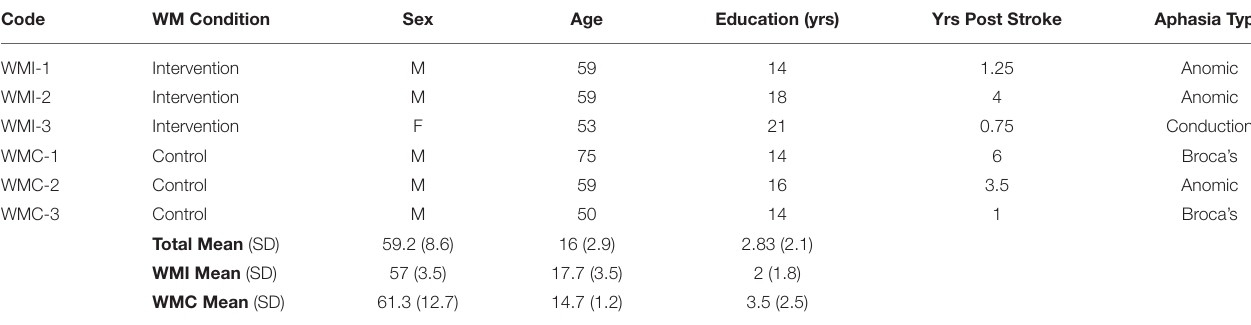
TABLE 1 | Individual participant